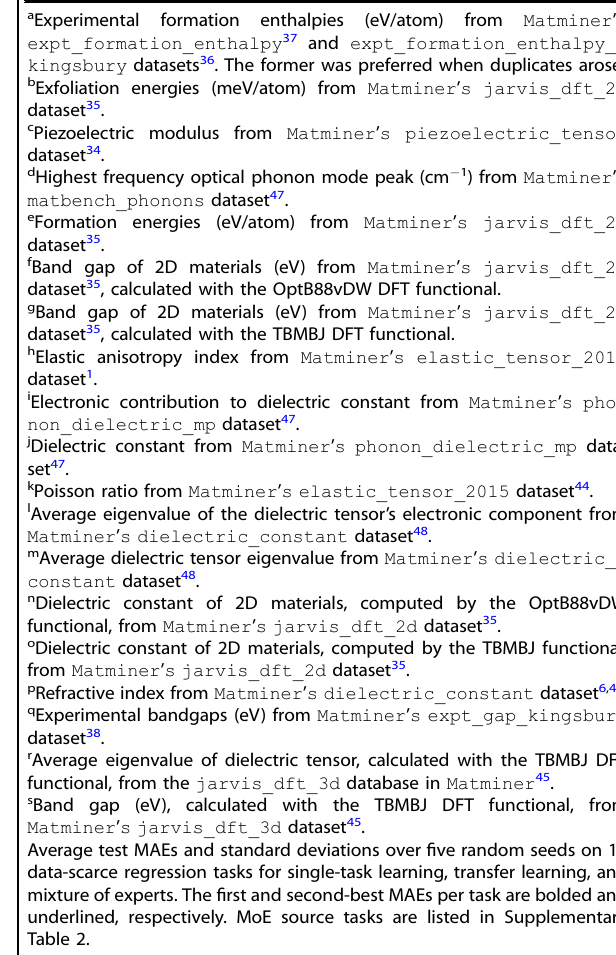
underlined, respectively. MoE source tasks are listed in Supplementary Table